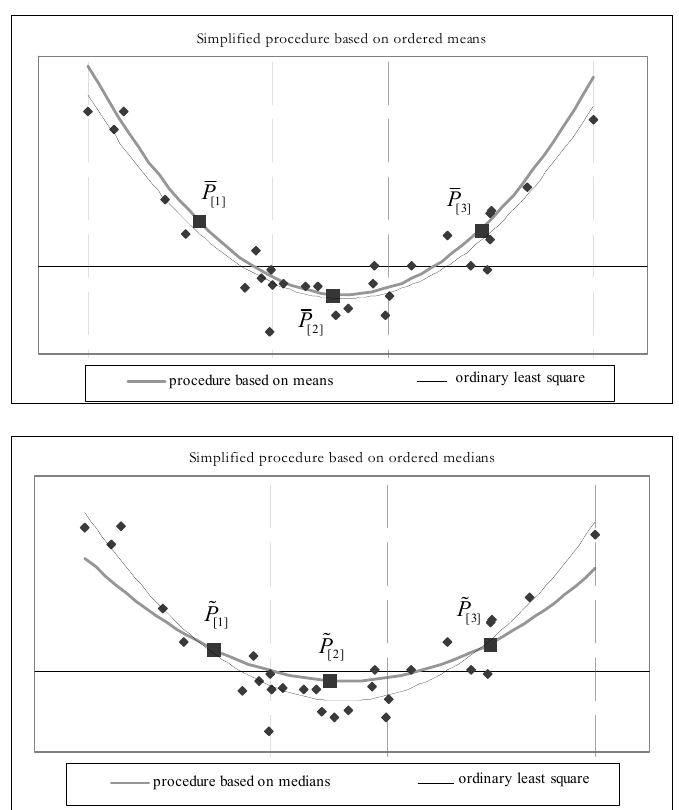
Figure 4 – The proposed simplified procedure: an example for n = 30, m = 3 and r = 2.